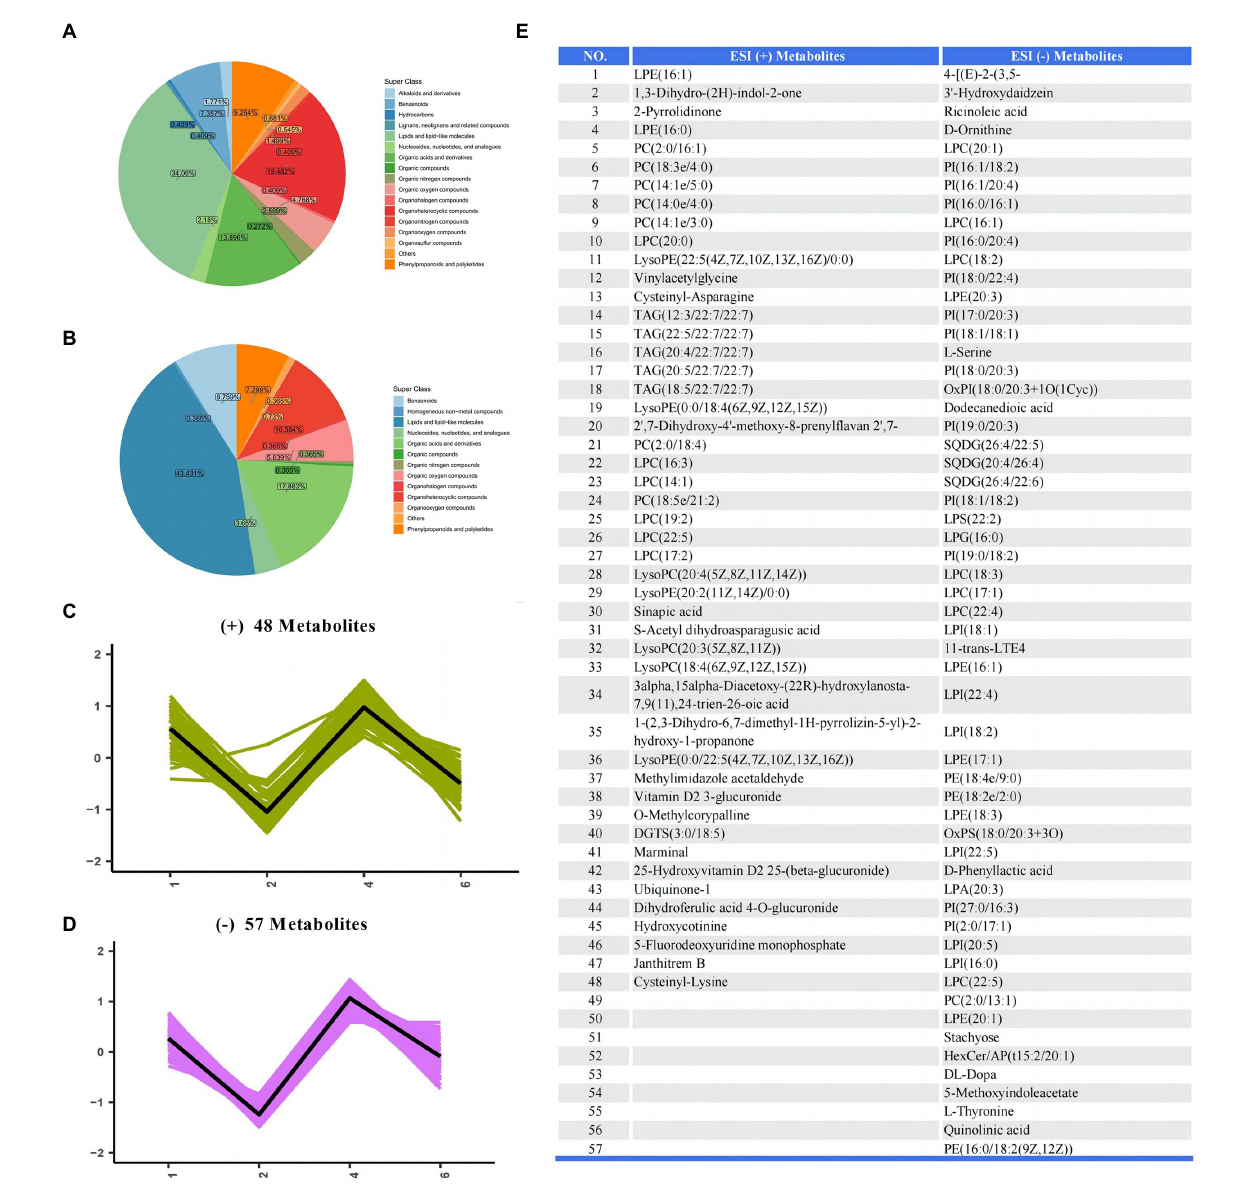
FIGURE 6 The differential metabolites of serum samples between groups. (A,B) Pie plot of metabolite classification based on the ESI (+) and ( − ) mode. (C,D) K -Means clustering analysis of different groups based on the ESI (+) and ( − ) mode. (E) The list of differential metabolites in